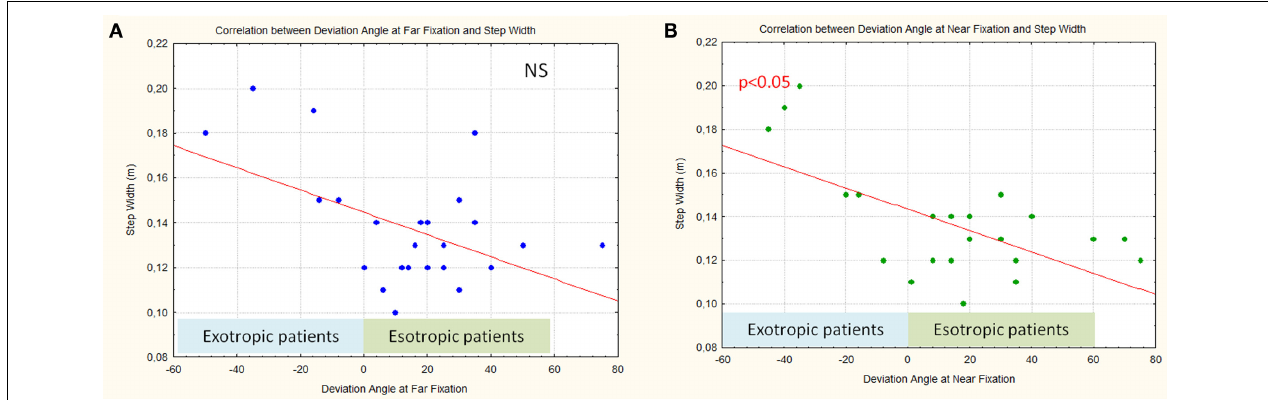
FIGURE 6 | Correlation between deviation angle values at far fixation (A) and near fixation (B) and step width.